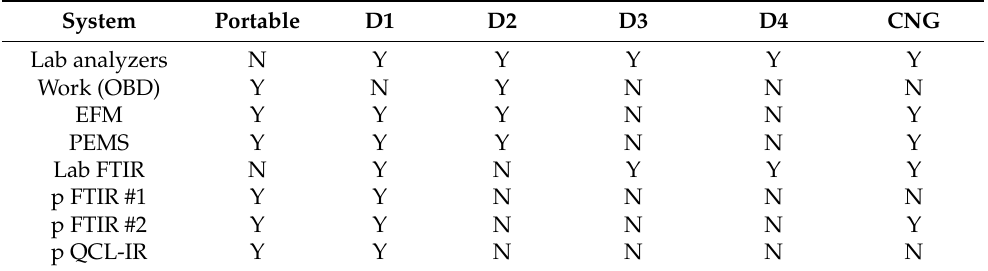
Figure 1. Schematic of experimental setup. EFM = exhaust flow meter; FTIR = Fourier transform infrared; p = portable; PEMS = portable emissions measurement system; QCL-IR = quantum cascade laser infrared. Table 1. Overview of tested parameters and the equipment of the various engines. Note that different portable and laboratory instruments were used with each engine (except for p FTIR #2).